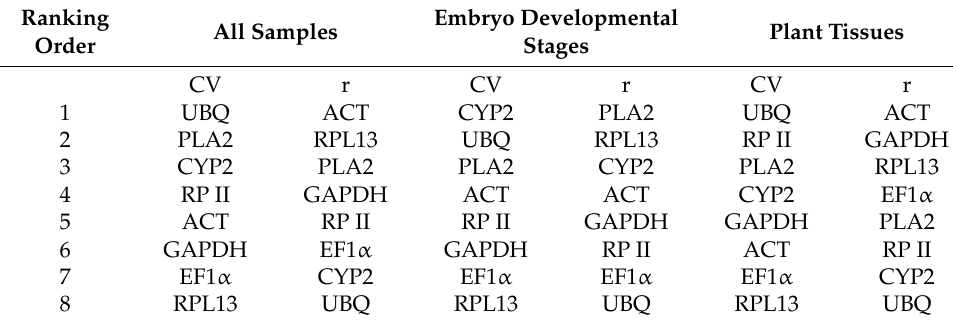
Table 4. Ranking of the eight genes according to correlations between reference genes and BestKeeper index.